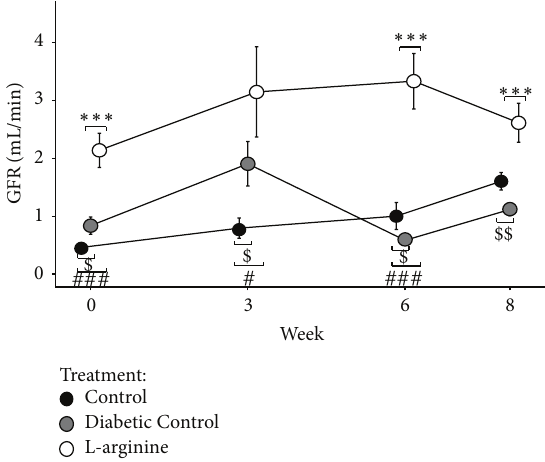
Figure 4: Effect of the high fructose diet alone and high fructose plus L-arginine diet on GFR over 8 weeks. Control versus Diabetic Control: $ 𝑃 < 0.05 and $$ 𝑃 < 0.01 ; Control versus L-arginine: # 𝑃 < 0.05 and ### 𝑃 < 0.001 ; Diabetic Control versus L-arginine: ∗∗∗ 𝑃 < 0.001 .